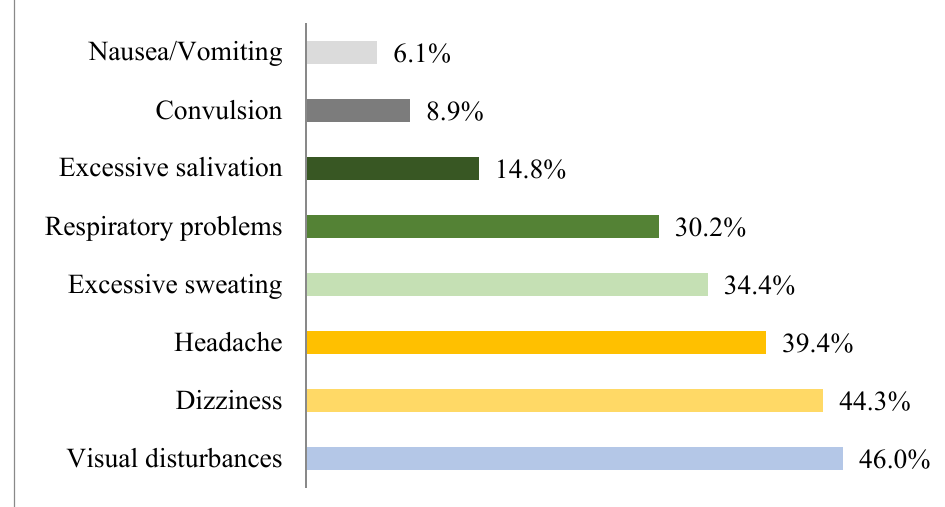
Figure 5. Self-reported symptoms by farmers after handling pesticides.